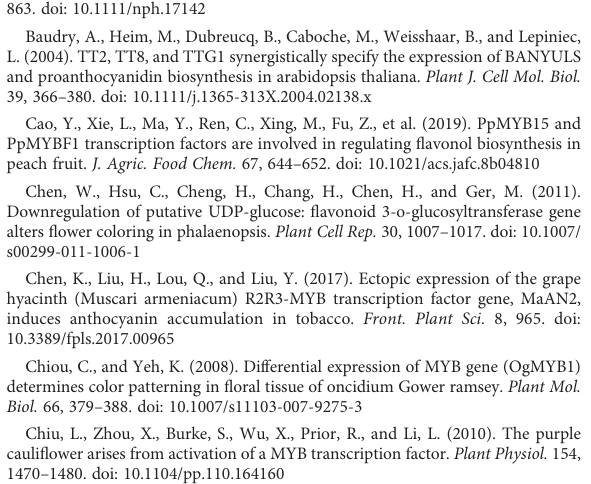
SUPPLEMENTARY FIGURE 1 Length distribution of unigenes in D. ‘ Suriya Gold ’ . Length distribution of unigenes identi fi ed in transcriptome assembly of D. ‘ Suriya Gold ’ . Total number (49,938), Total length (96,387,028 nt), Mean length (1930.13 nt), N50 length (2837 nt). N50 is de fi ned as the length of the longest unigene such that all unigenes of at least N50 length contain greater than 50% of all bases in the transcriptome assembly. SUPPLEMENTARY FIGURE 2 COG and KOG functional classi fi cations of unigenes in D. ‘ Suriya Gold ’ . (A) COG (Cluster of orthologous groups) functional classi fi cations of unigenes. (B) KOG (Eukaryotic Ortholog Groups) functional classi fi cations of unigenes. The x-axes represent COG or KOG categories, and the y-axes represent the number of unigenes annotated. SUPPLEMENTARY FIGURE 3 Analyses of color in different fl oral tissues of “ BP ” hybrid progenies during fl owerdevelopment.Colorimetricanalysesofsepals (A ),petals (B) andlips (C) of “ BP ” hybrid progenies at different developmental stages in three- * a * b * system. dimensional color space using the CIE L